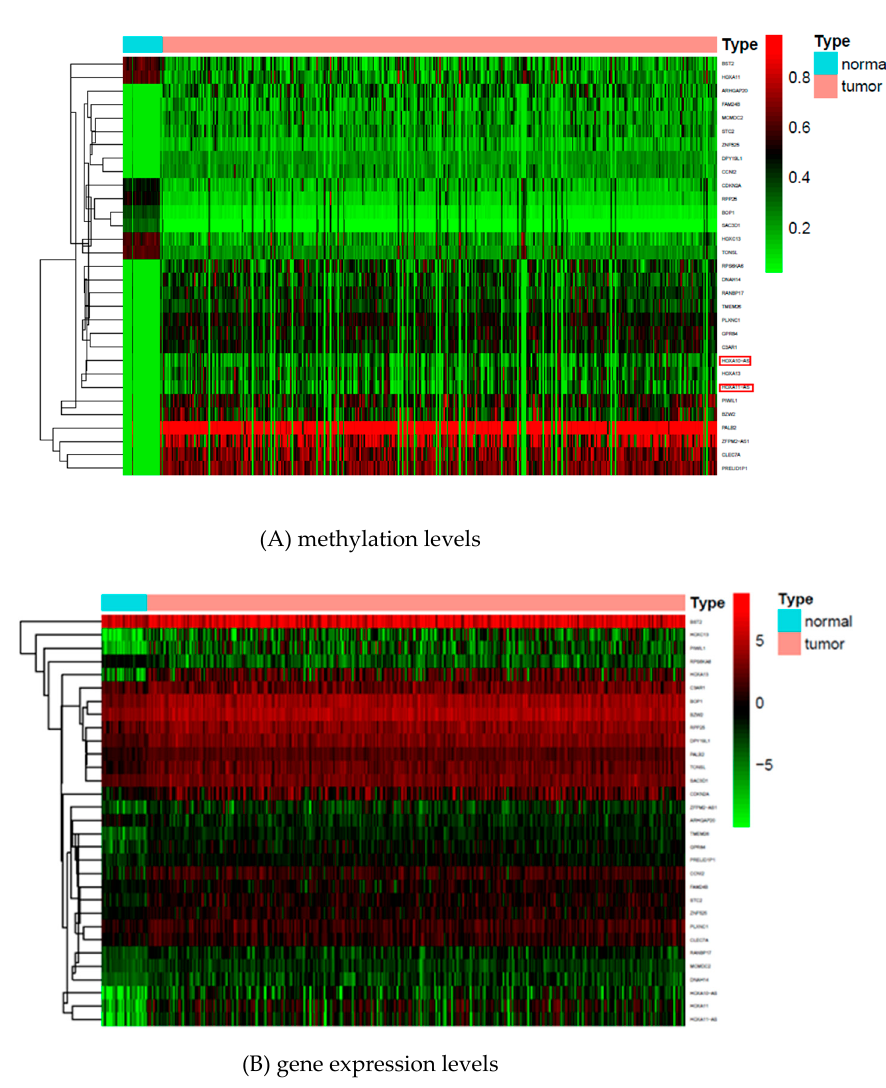
Figure 5. Heatmap of methylation and expression levels based on these 31 driven genes.